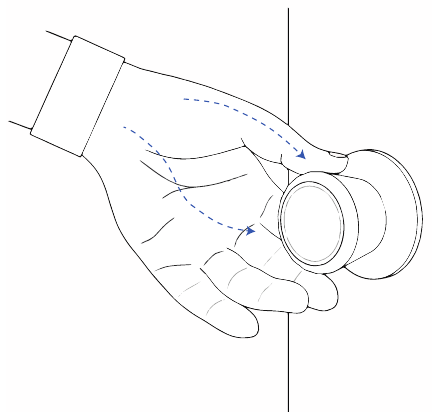
Figure 8. Application to a doorknob with a vibration sensor embedded. Either original